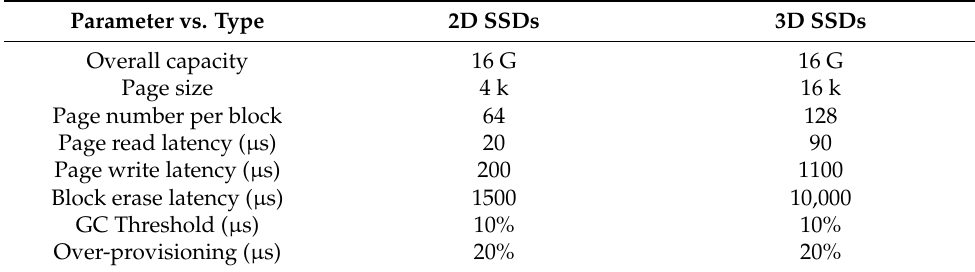
Table 1. Parameter configurations of 2D SSDs and 3D SSDs.